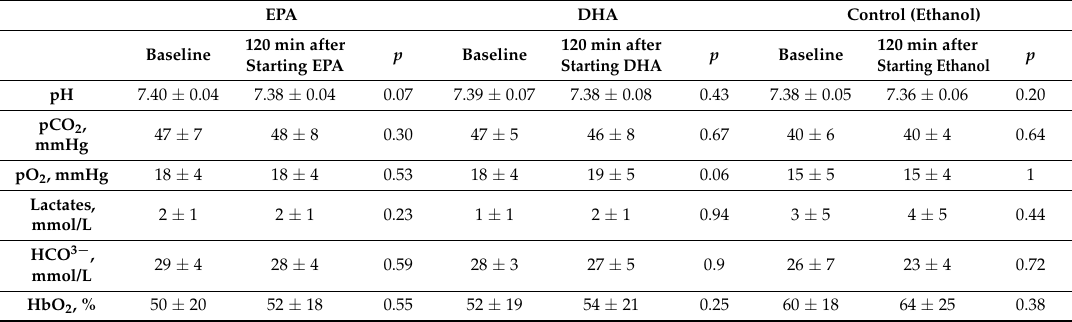
Table 1. Blood gases, hemoglobin saturation and plasma lactates concentration before and 120 min after starting infusion of eicosapentaenoic Acid (EPA, n = 8), docosahexaenoic Acid (DHA, n = 7) or control (ethanol, n =